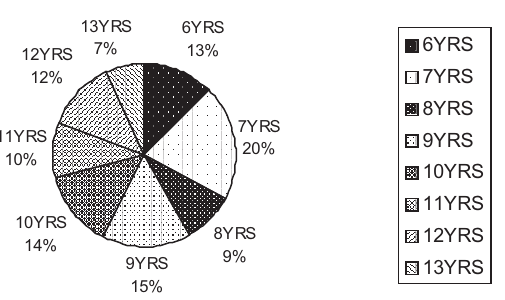
Figure 3: Shows the percentage of children who had reduced lag of accommodation in each age group. The highest percentage was among the 7 year